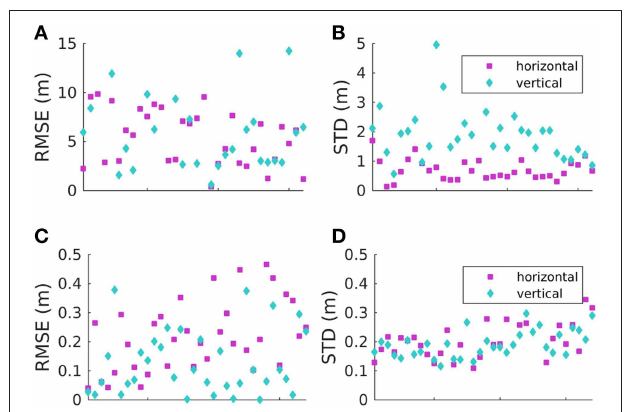
FIGURE 4 | Horizontal and vertical RMSE (A,C) and STD (B,D) of the shifts of bedrock zones between repeat surveys inferred by template matching on ortho-images and DEM differentiation. Results of the field campaigns 2017 and 2018 are given separately. Note the different scales on the vertical axes.